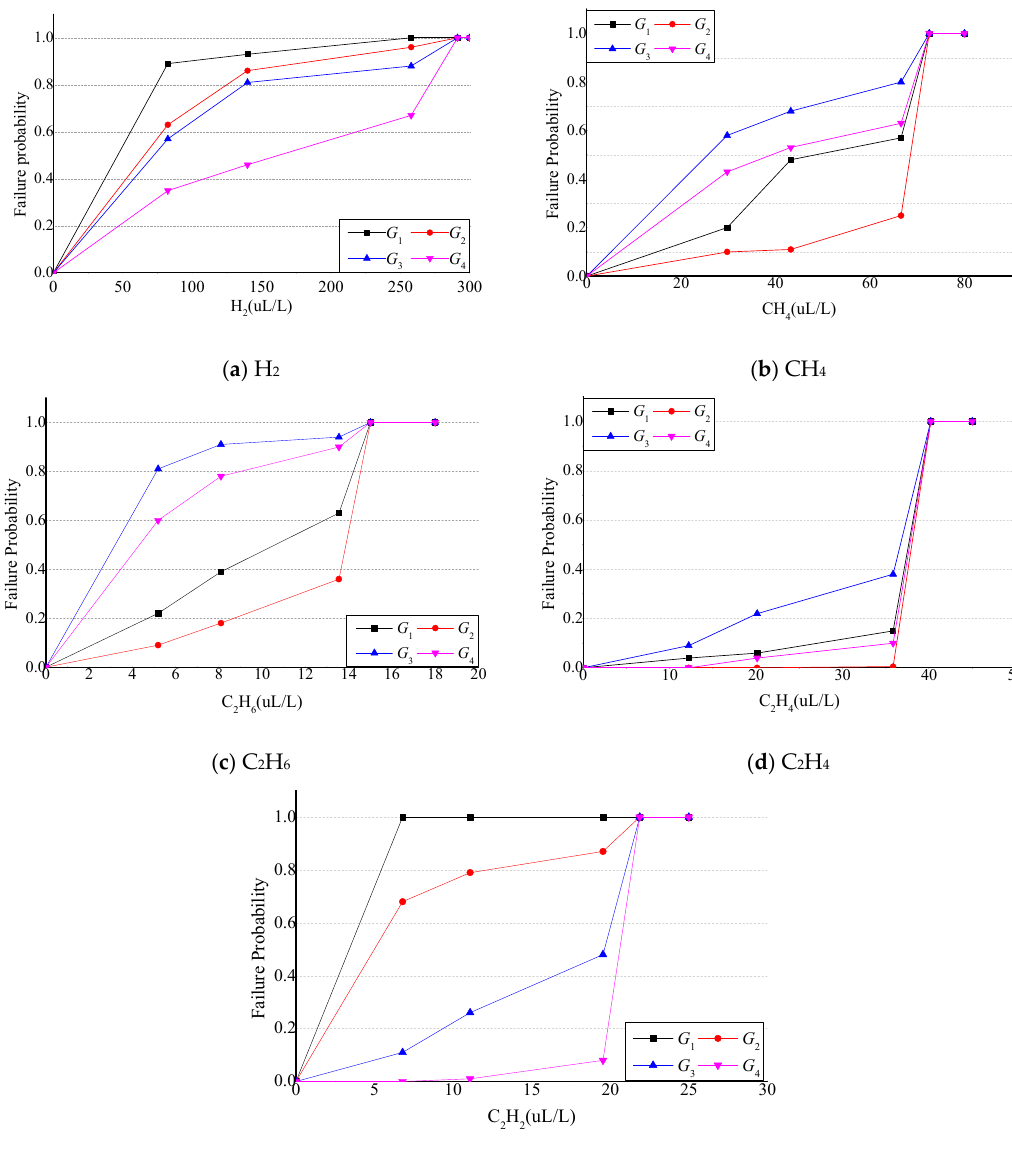
Figure 6. The membership functions of the dissolved gas.